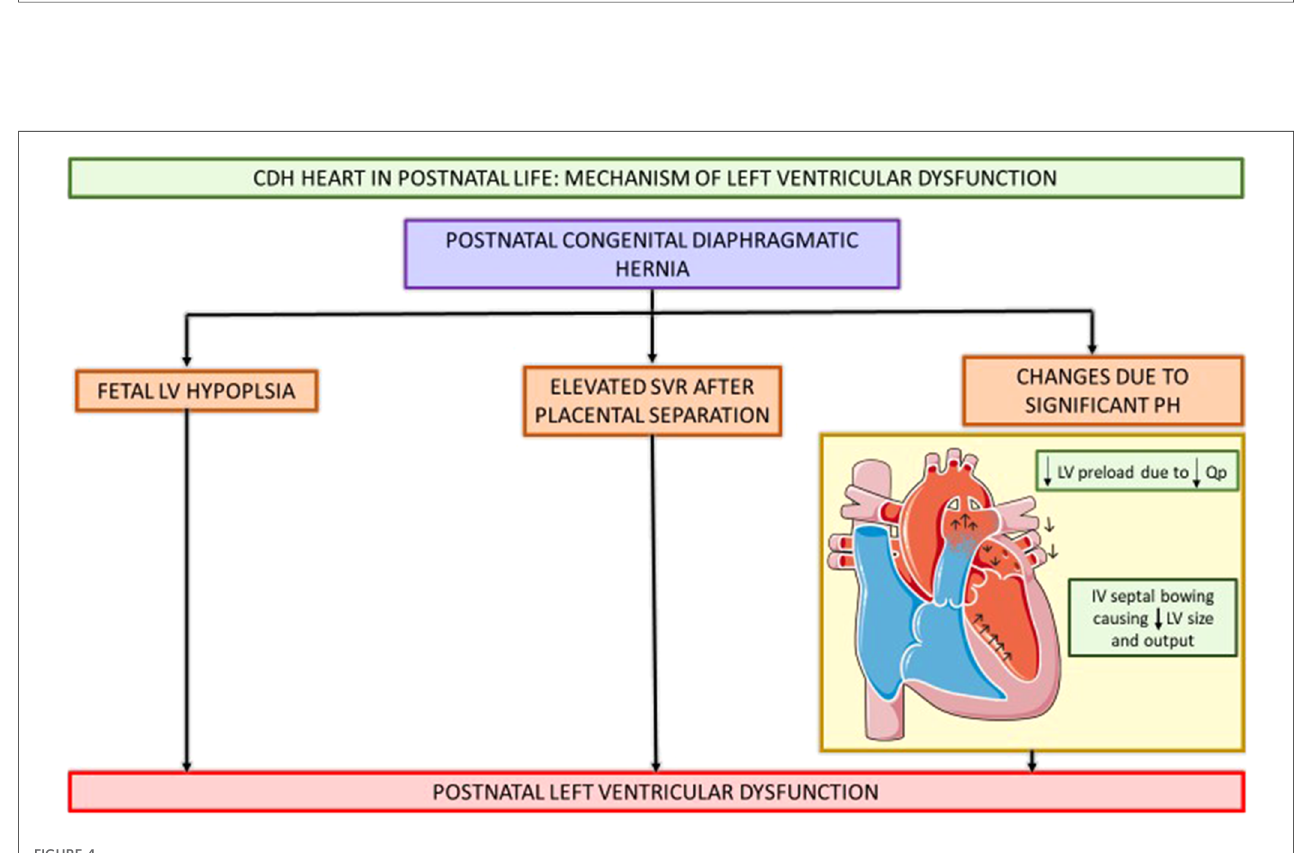
FIGURE 4 Schematic showing CDH heart in postnatal life and pathophysiology contributing to postnatal LV hypoplasia and systemic hypotension. CDH, congenital diaphragmatic hernia; Qp, pulmonary blood fl ow; LV, left ventricle; SVR, systemic vascular resistance; IV, intraventricular septum. (This Figure was partly generated using Servier Medical Art, provided by Servier, licensed under a Creative Commons Attribution 3.0 unported